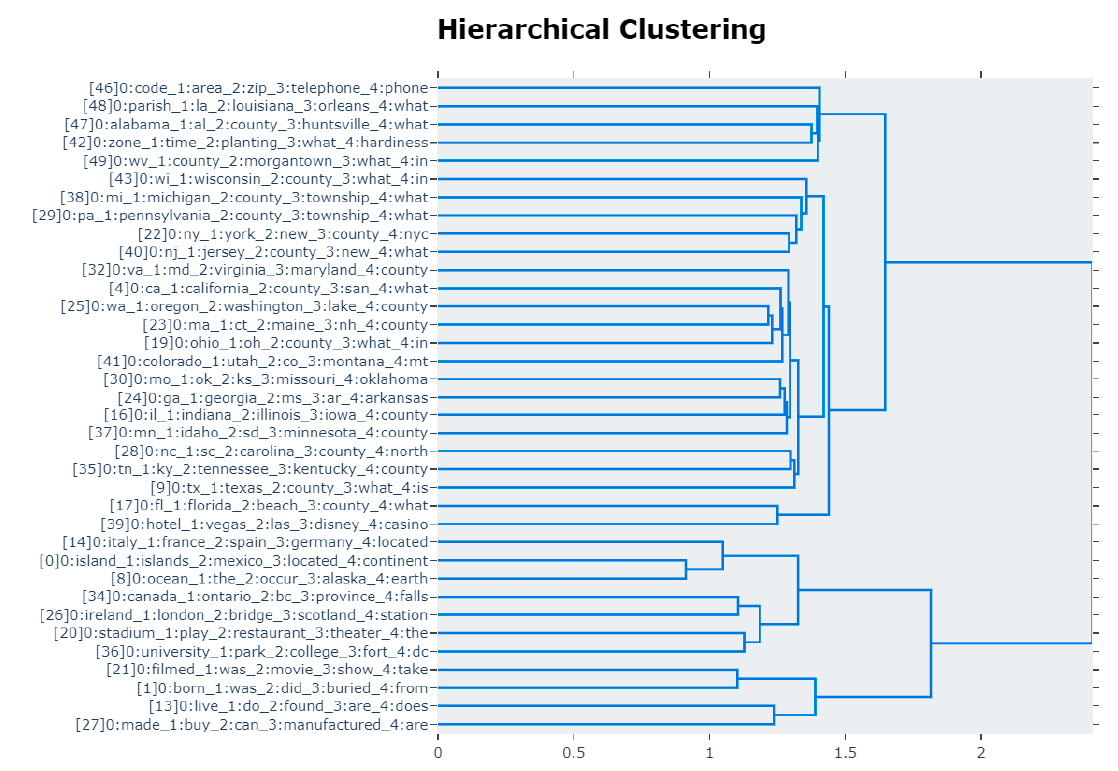
Figure 7. Latent topics of geographic questions in MS MARCO. Hierarchical clustering in this figure is only for visualization purposes. We discovered the users’ interest regarding geographic domains by investigating the latent topics. For example, people are interested in time zones (topic 42), zip or area codes (topic 47), and where something is made or can be bought (topic 27).